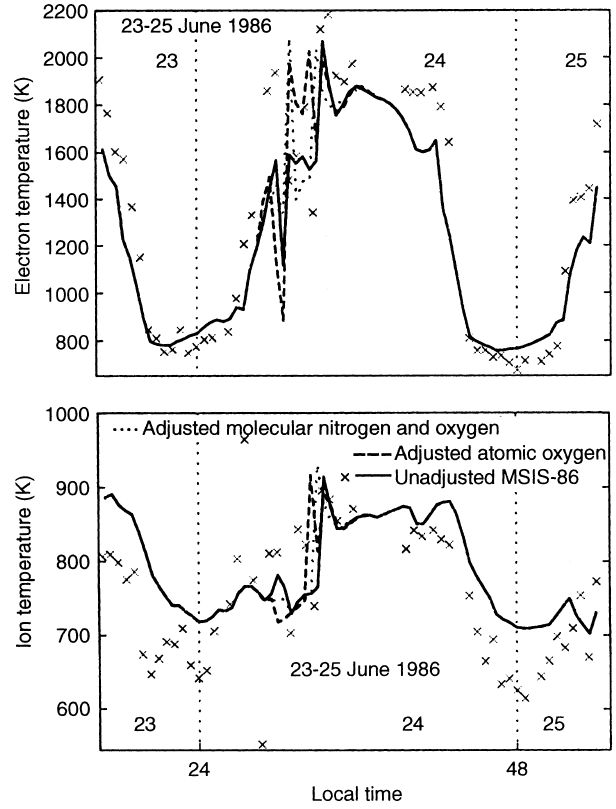
Fig. 2. Observed ( crosses ) and calculated ( lines ) electron ( top ) and ion ( bottom ) temperatures at the height of the F 2 peak for 23–25 June 1986. The solid , dashed , and dotted lines are the same as for